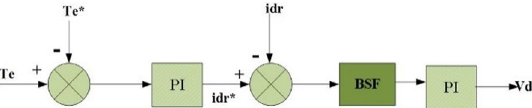
Fig. 14 Feedforward filtering